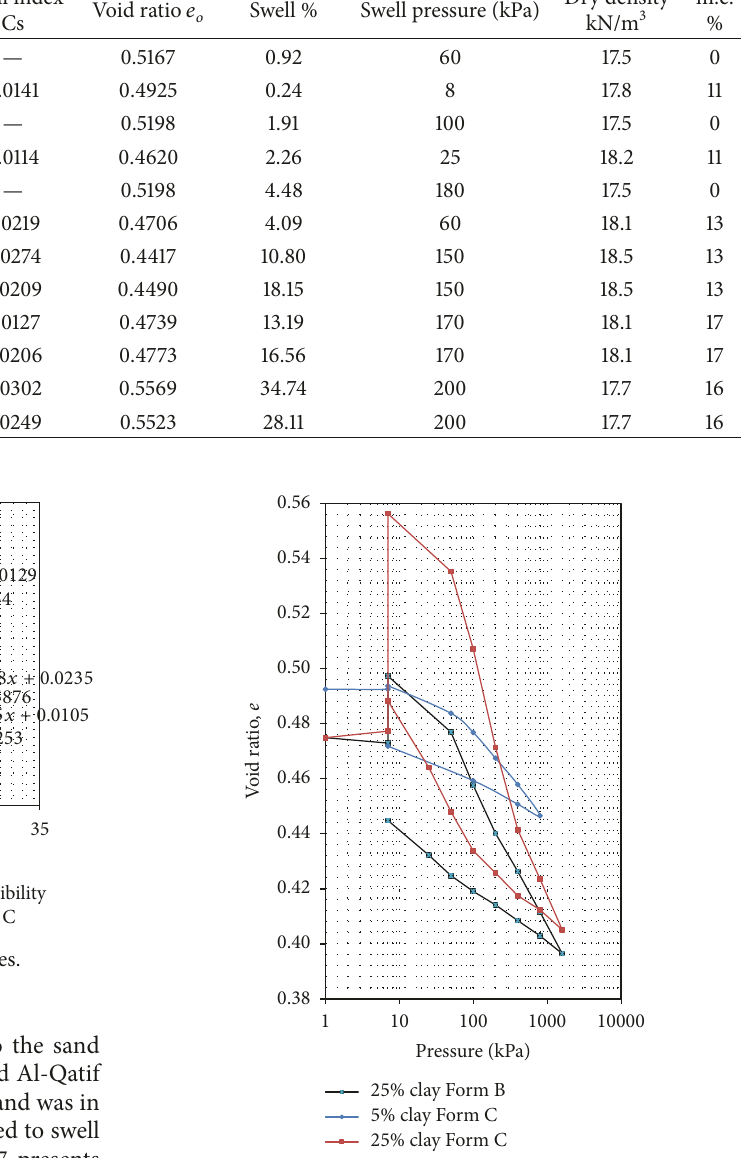
Figure 10: Swell-compressibility profiles for selected ratios (25% of Form C and 25% of Form B clay compared to 5% clay Form